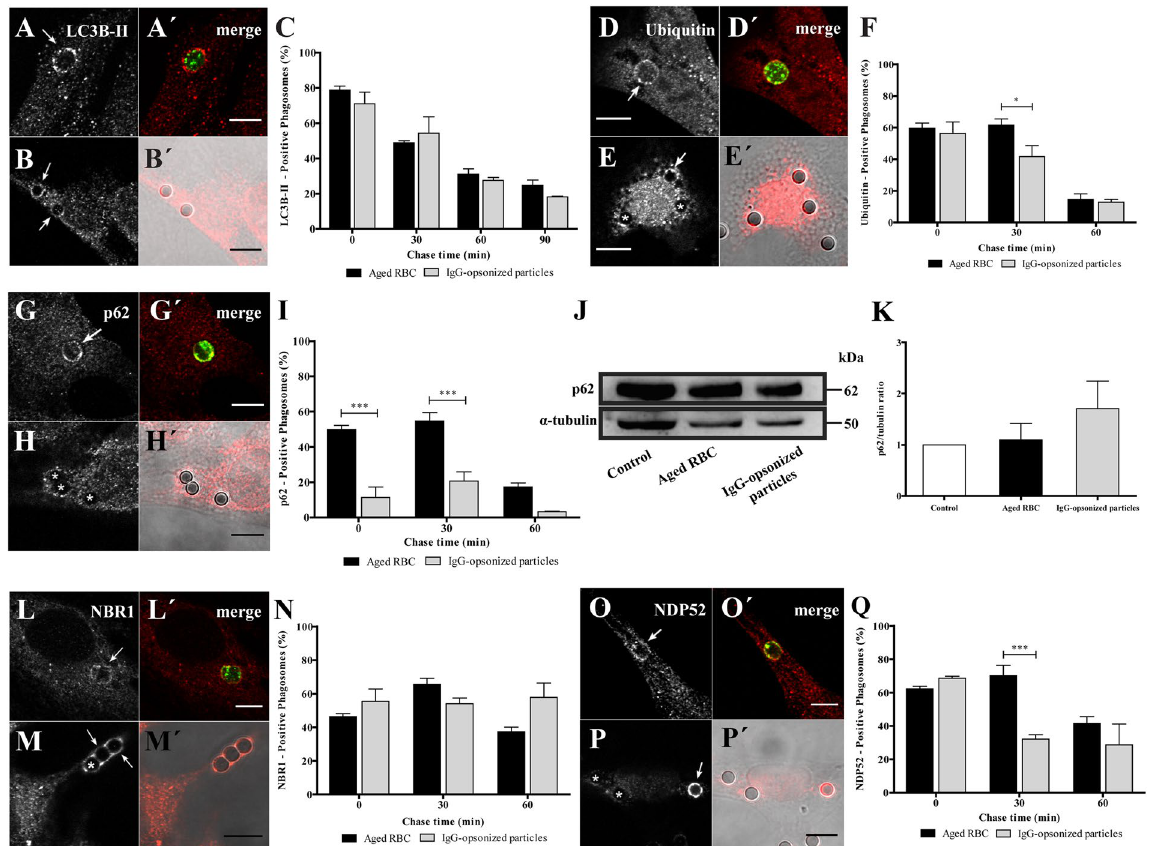
Figure 1. Acquisition of LC3B-II and autophagy adaptor proteins by phagosomes in non-professional phagocytes. Phagocytes were challenged with RBC ( A ,A ′ , D ,D ′ , G ,G ′ , L ,L ′ O and O ′ ) or with IgG-opsonized particles ( B ,B ′ , E ,E ′ , H ,H ′ , M ,M ′ , P and P ′ ) and then immunostained for the endogenous LC3B, ubiquitin, p62, NBR1 and NDP52 as indicated in the different figure panels. ( A , B , D , E , G , H , L , M , O and P ) are immunofluorescence images. (A ′ ,B ′ ,D ′ ,E ′ ,G ′ ,H ′ ,L ′ ,M ′ ,O ′ and P ′ ) are the composite of the immunofluorescence image with the phagocytic particles visualized in green (RBC stained with CFSE) or by differential interference contrast (DIC, IgG-opsonized particles). In ( A ,B ′ and G ,H ′ ) images were acquired at 0 min chase time. In ( D ,E ′ , L ,M ′ and O ,P ′ ) the images were acquired at 30 min chase time. Arrows indicate positive- and asterisks ( * ) indicate negative-phagosomes for the indicated endogenous protein. Bars, 10 µ m. ( C , F , I , N and Q ), Graphs showing the percentage of positive phagosomes for LC3B-II, ubiquitin and the different adaptor proteins. Quantifications were performed in non-professional phagocytes exposed to the different phagocytic particles for 30 min and chased for the times indicated in the graph abscissa. The values are means ± SEM of, at least, three independent experiments. At each time point, at least, 50 phagosomes were analyzed. * p < 0.05; *** p < 0.001 comparing differences between phagosomes with RBC and with IgG-opsonized particles. ( J ) p62 levels in cell lysates of non-professional phagocytes exposed for 30 min to RBC or to IgG-opsonized particles. α -tubulin was used as loading control. ( K ) Ratio of p62/tubulin of quantified bands in cells exposed or not (control) to RBC or IgG-opsonized particles. Three independent experiments were